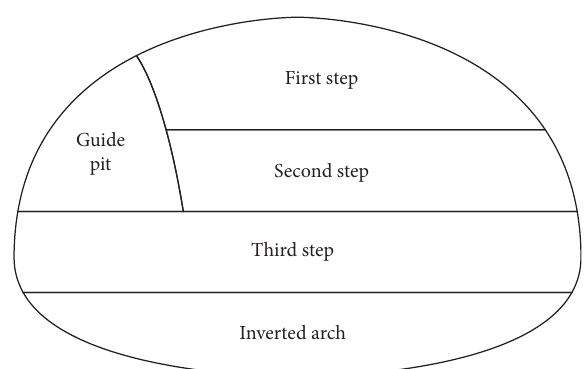
Figure 7: Construction sketch of the single-side guide pit